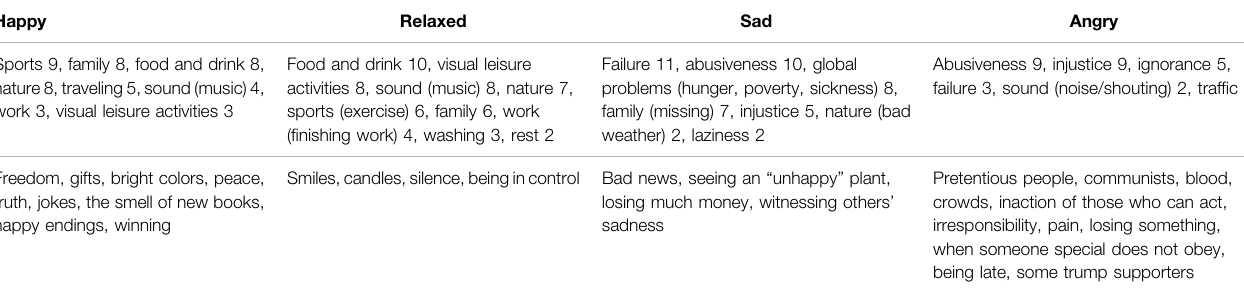
TABLE 2 | Representational symbols disclosed by more than one participant as eliciting emotions. The top row indicates “ typical ” symbols described by more than one participant.Herethenumbersbesideeachcodedlabelindicatethenumberofmentioningparticipants,symbolsthatelicitedmorethanonekindofemotionareindicated in bold, and comments in parentheses are given for clari fi cation. The bottom row holds symbols indicated by only a sole participant.